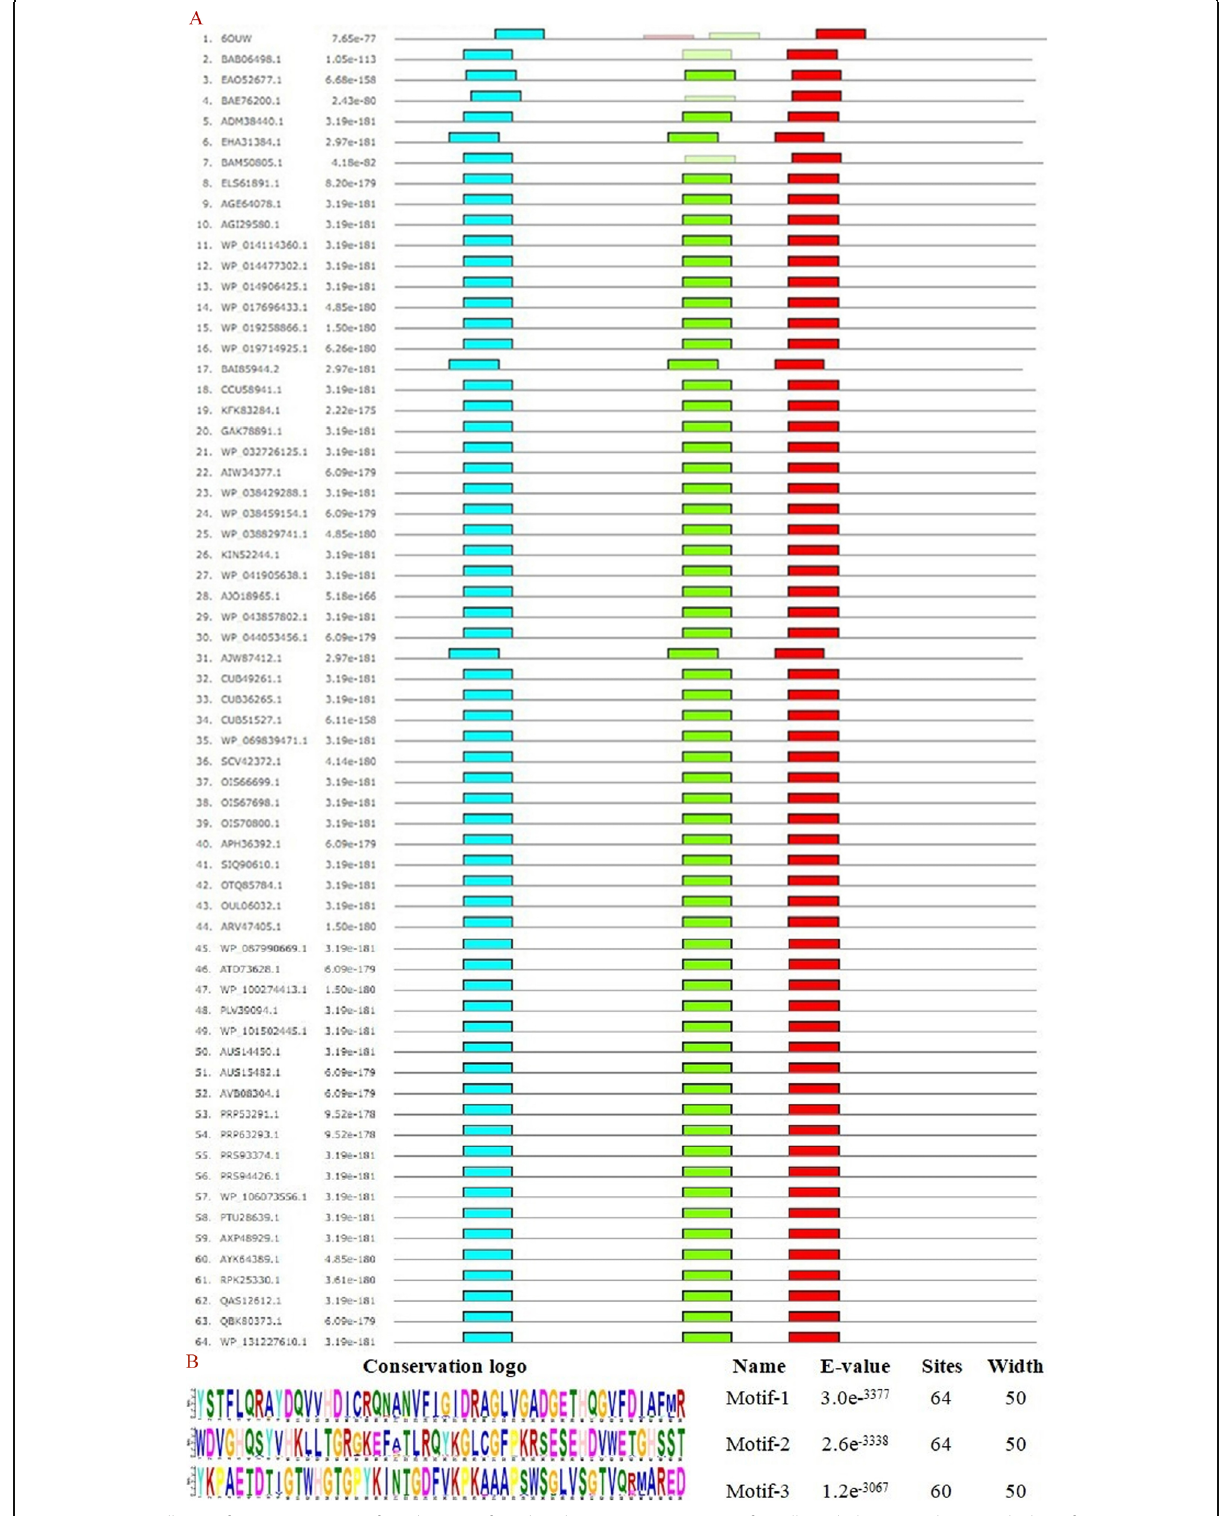
Fig. 9 a Statistically significant occurrence of tandem motifs within the 63 DXS sequences of Bacillus subtilis, in correlation with the reference structure 6OUW. Motifs 1 and 3 are found statistically conserved across all homologs. b Conservation logo and statistical E value scores of localized